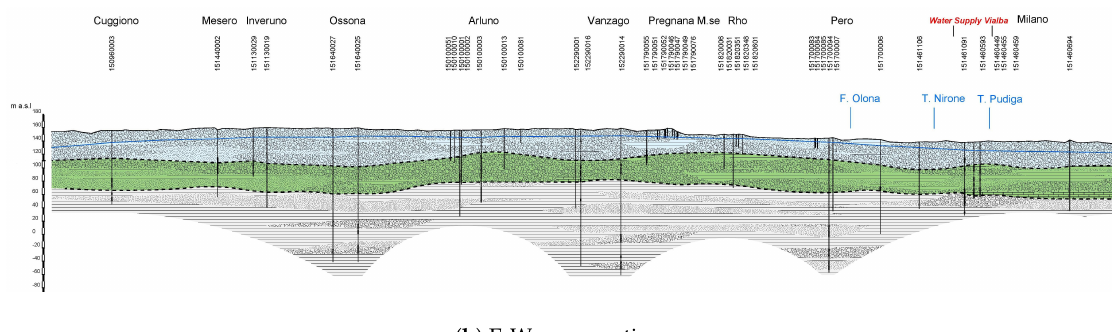
Figure 2. Hydrogeological cross-section ( a ) N-S (blue line) and ( b ) E-W (red line) of the Pilot Area represented in Figure 1b. The light-blue represents the Aquifer A whereas the green represents the Aquifer